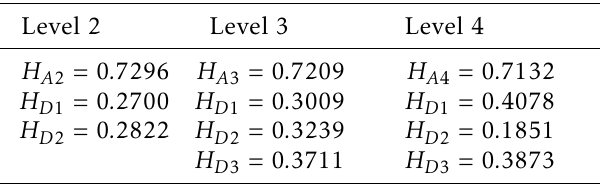
Table 1. Level 2-4 wavelet decomposition with hurst